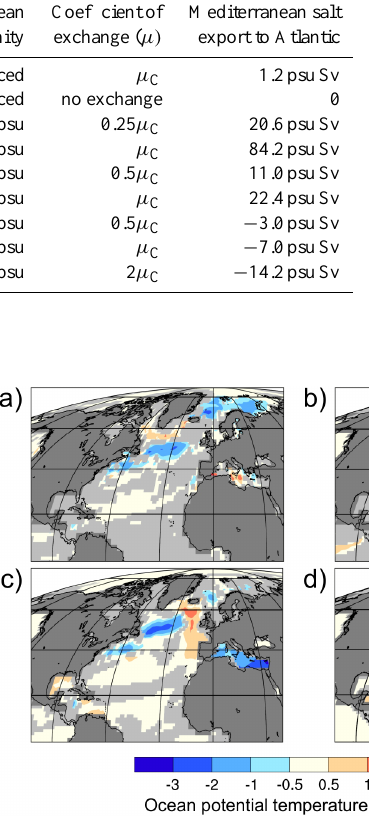
Fig. 7. North Atlantic annual mean ocean potential temperature anomalies (in ◦ C) for no-exchange with respect to Messinian con- trol at a depth of (a) 5m (b) 67m, (c) 301m and (d) 996m. Conti- nental land masses are masked in dark grey. Anomalies with < 95% confidence in significance using a student t test are masked in light